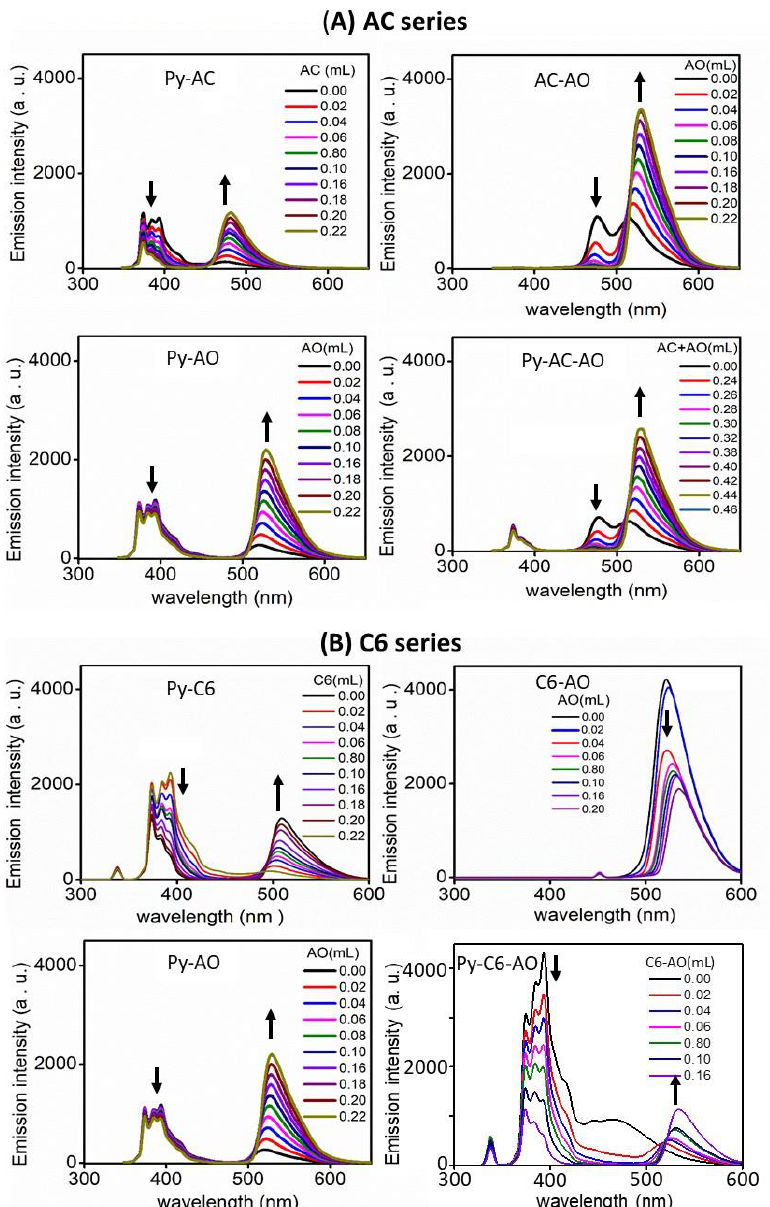
Figure 4. Emission spectra of ethanol solutions of ( A ) Py(3 µ M)-AC, Py(3 µ M)-AO, AC(3 mM)-AO and Py(3 µ M)-AC(3 mM)-AO and ( B ) Py(3 µ M)-C6, Py(3 µ M)-AO, C6(3 mM)-AO and Py(3 µ M)- C6(3 mM)-AO.